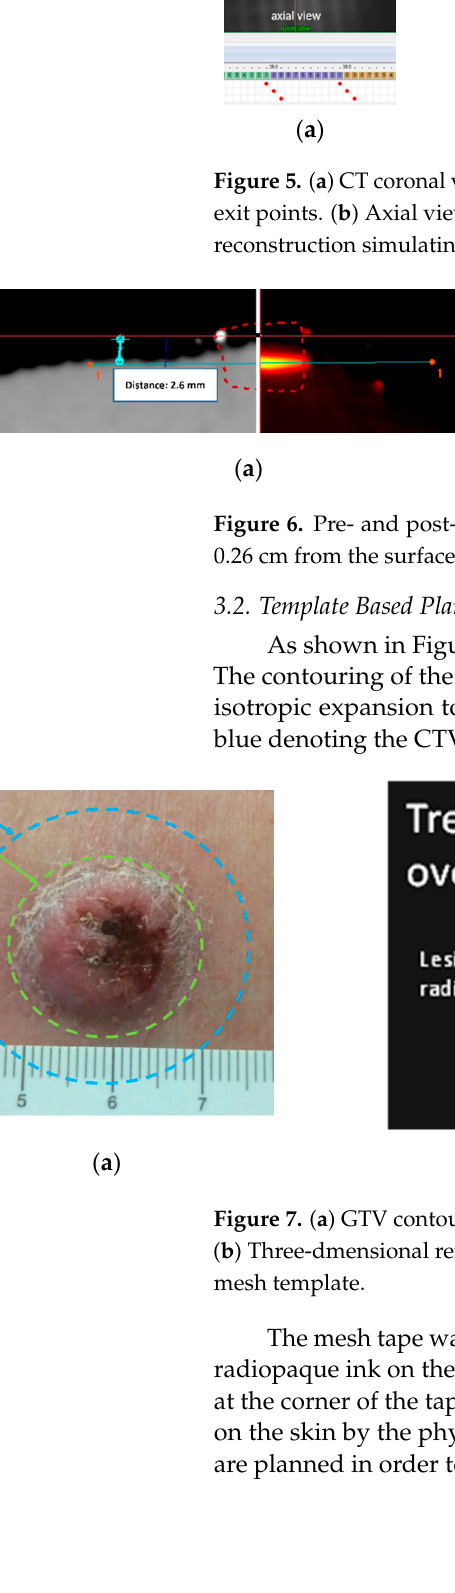
Figure 5. ( a ) CT coronal view of the radio-opaque contouring of the lesion with needles’ insertion and exit points. ( b ) Axial view of the lesion contoured with dotted red line and brachytherapy cath- eters reconstruction simulating needles displacement. ( c ) Detail of the needle insertion procedure.